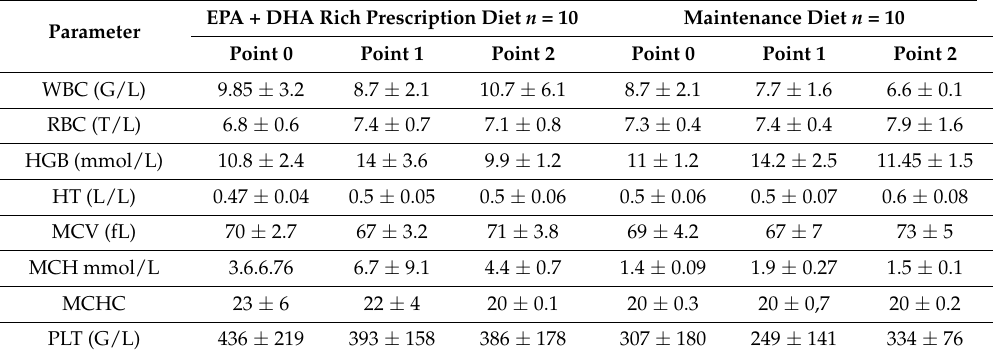
WBC: white blood cell count; RBC: red blood cell count; HGB: concentration of hemoglobin; HT: hematocrit; MCV: mean red cell volume; MCH: mean mass of hemoglobin in the red cell; MCHC: concentration of hemoglobin in the red cell; PLT: platelet (thrombocytes)